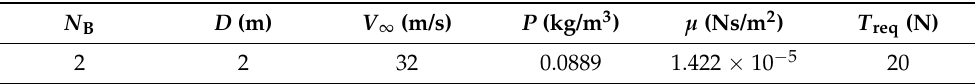
Figure 15. The ultra-high-altitude unmanned aerial vehicle for case study. Table 4. Parameters of propeller and the design state.